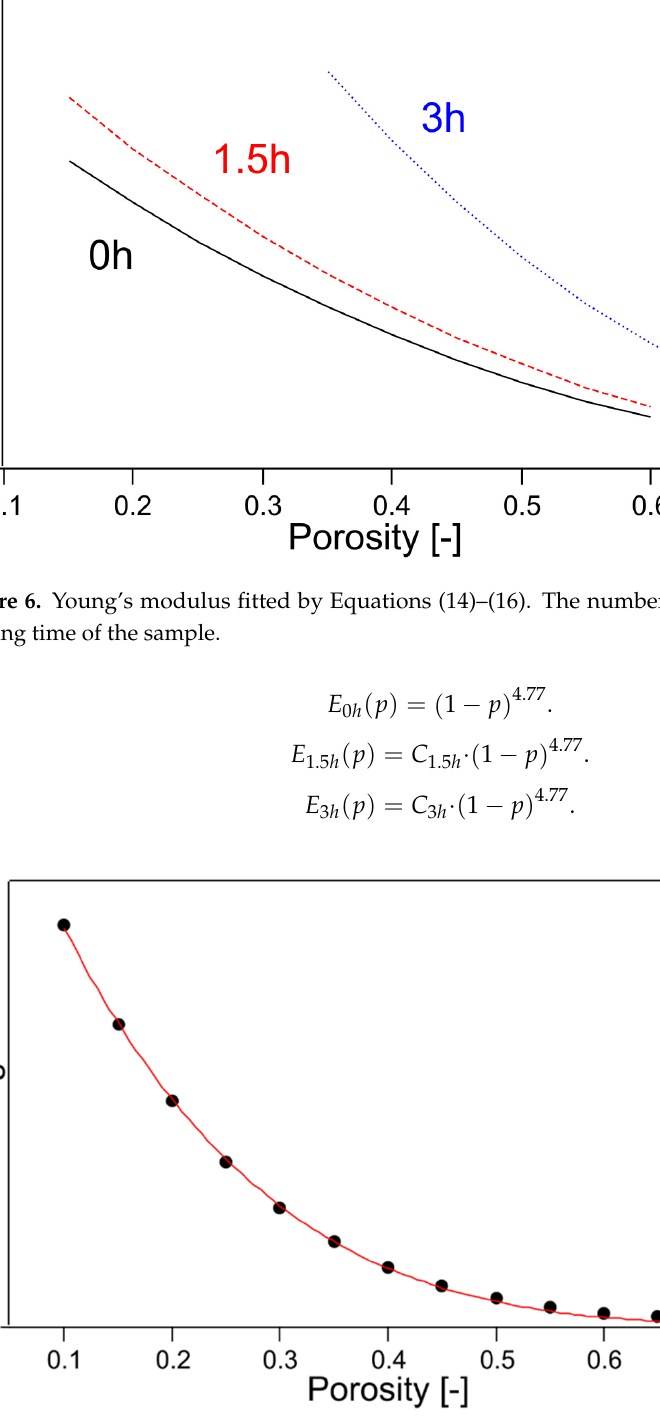
Figure 6. Young’s modulus fitted by Equations (14)–(16). The numbers in the figure indicate the heating time of the sample.